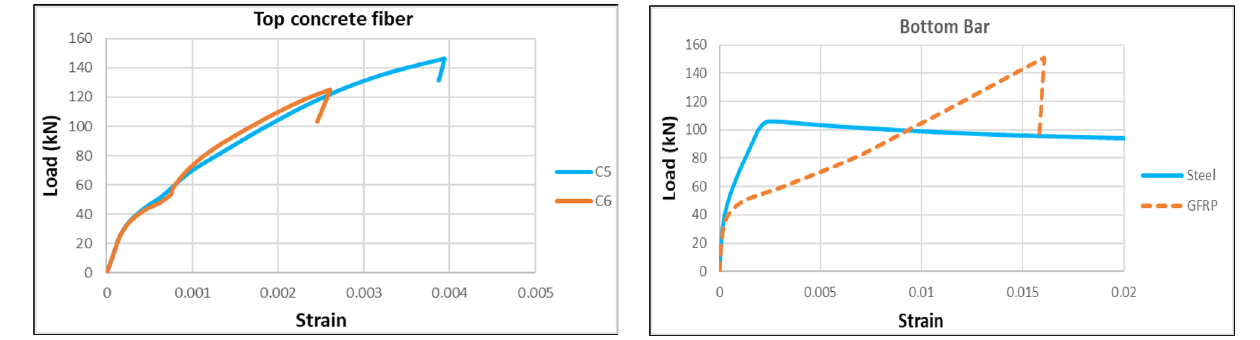
Figure 13: Strain in top concrete fi ber for specimens beams C5 and C6.